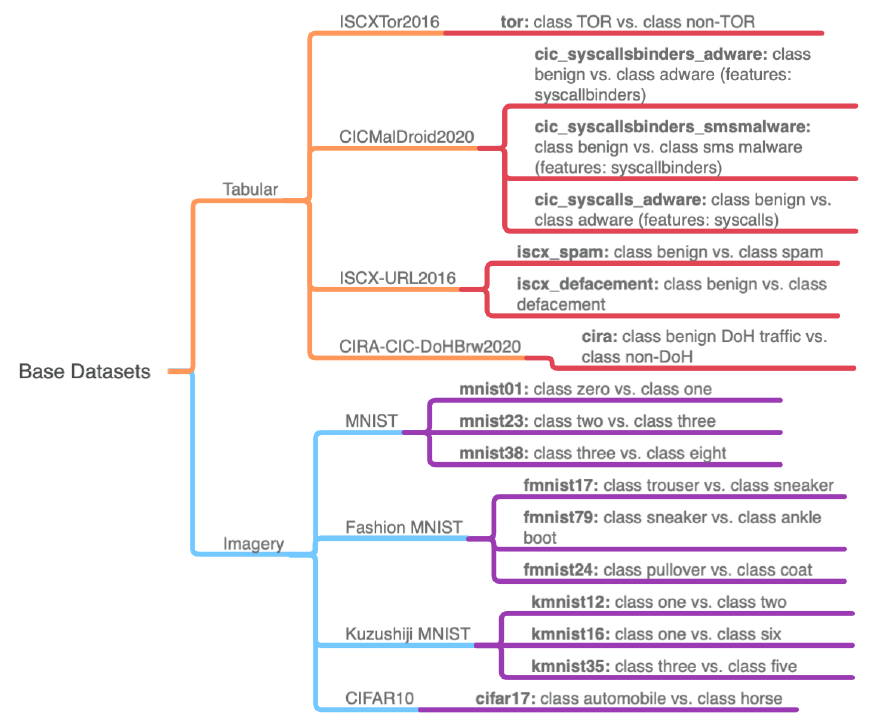
Figure 8. The base datasets (in blue and orange) used for creating 17 binary datasets (in red and purple). Dataset name and respective classes shown in the rightmost